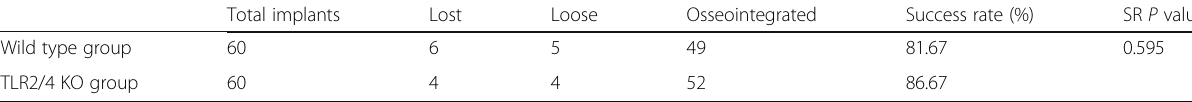
Table 1 Success rate (SR) of osseointegrated implants 4 weeks after implant placement Total